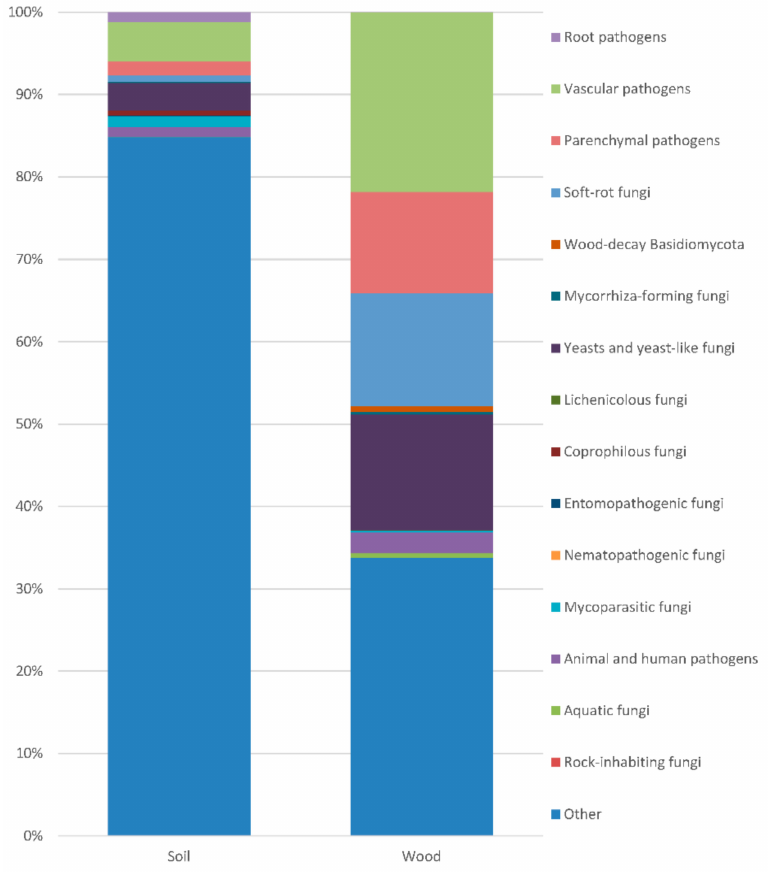
Figure 4. Frequency of the fungi in specific trophic groups. Individual taxa of obligate or facultative phytopathogens were more or less frequent. The root pathogens included species of Aphanomyces , Globisporangium , Phytophthora and Pythium (Oomycota: 1.17%), and Truncatella (Ascomycota: 0.003% in the soil, 0. 001% in the